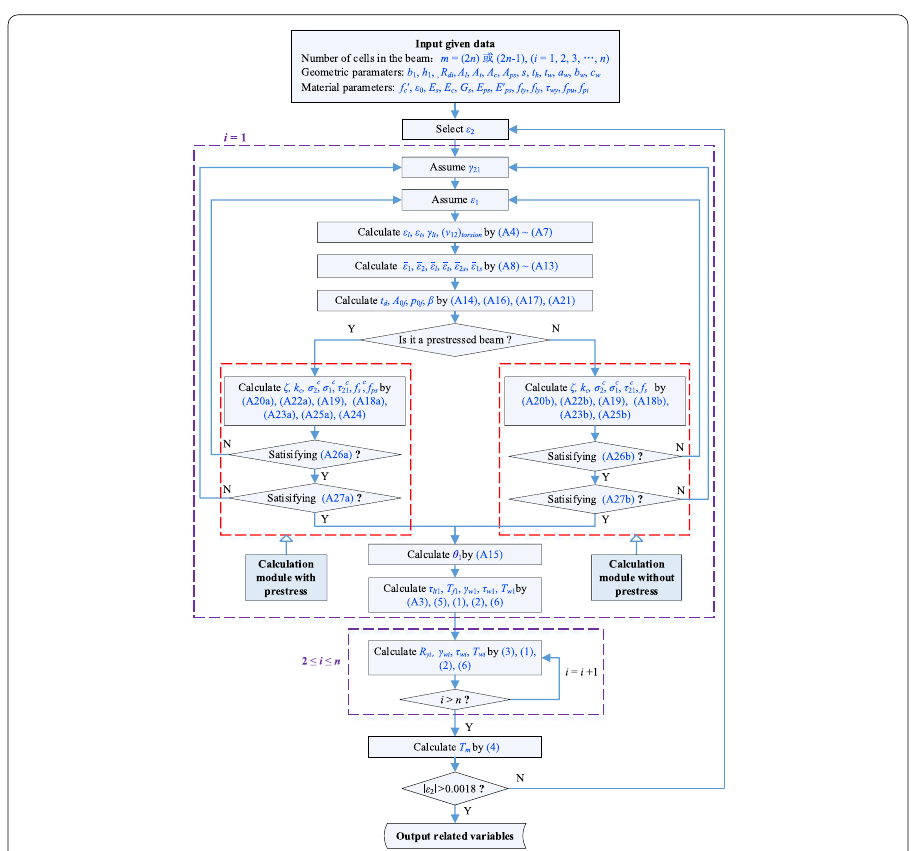
Fig. 4 Flow chart of solution procedure for the USMMT in single-box multi-cell